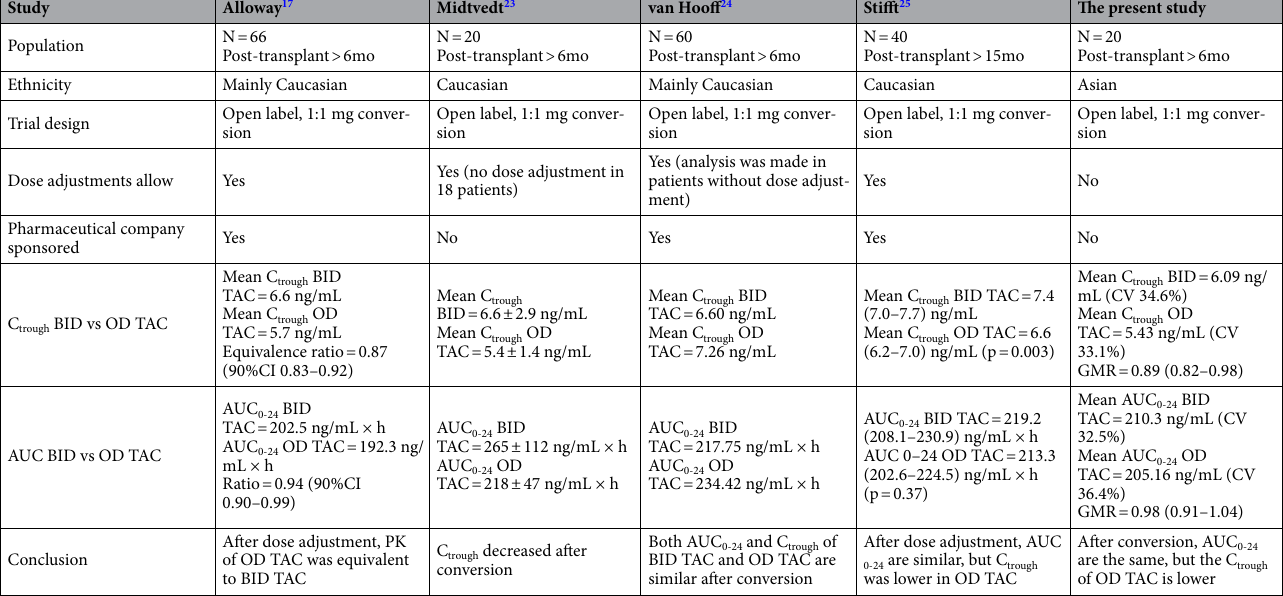
Table 6. Prospective study of 1:1 mg conversion from BID to OD TAC in stable adult kidney transplant recipients with AUC 0-24